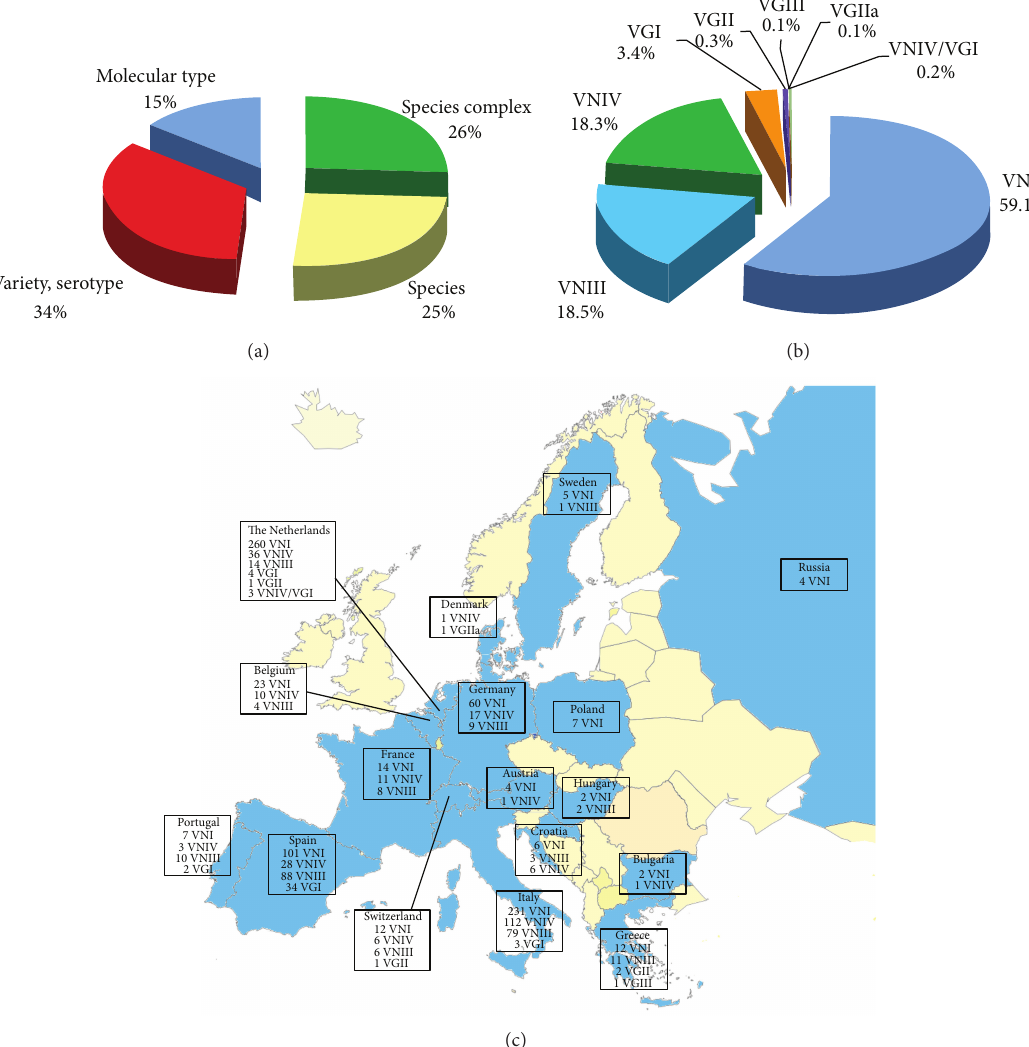
F 8: Percentage of Cryptococcus neoformans and Cryptococcus gattii isolates ( variety/serotype, or molecular type level (a). Prevalence of the di�erent VN and VG molecular types among the isolates identi�ed at molecular type level